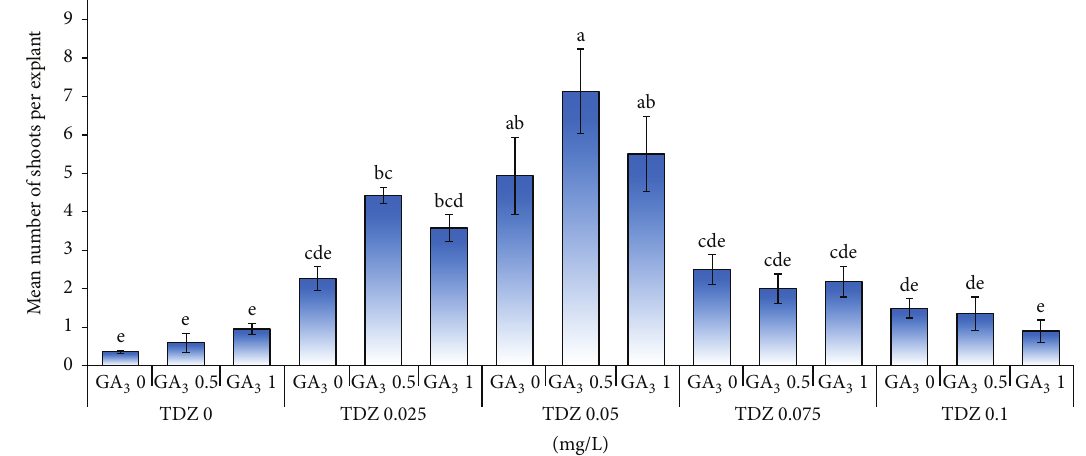
Figure 6: Effect of different concentrations of TDZ (mg/L) in combination with GA 3 (mg/L) on the number of shoots per